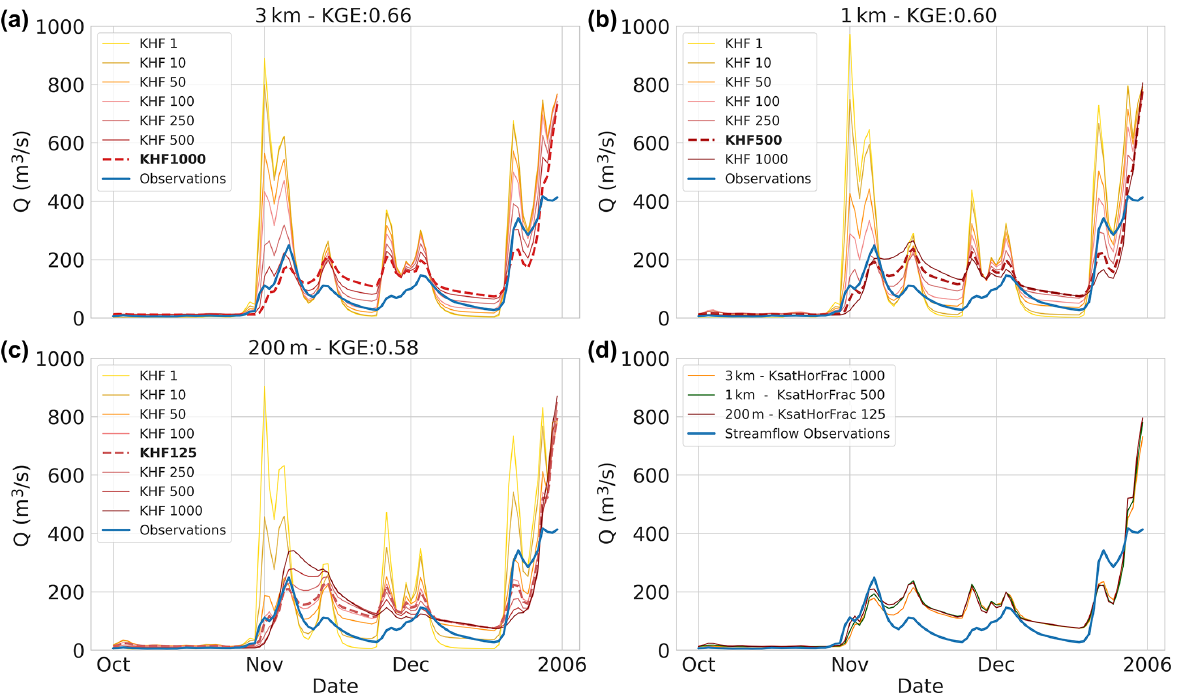
Figure 3. Calibration period results – the calibration interval of the KsatHorFrac (KHF) parameter for the three model instances at the basin outlet (ID:14301000) of the final calibration-period year: (a) 3km model instance, (b) 1km model instance, and (c) 200m model instance. Values range from 1 to 1000 (yellow to red) and only a sub-selection is shown. Best-performing calibration values are indicated with a dotted red line and streamflow observations in blue. (d) Best streamflow estimates of the 3km (orange), 1km (green), and 200m (red) model